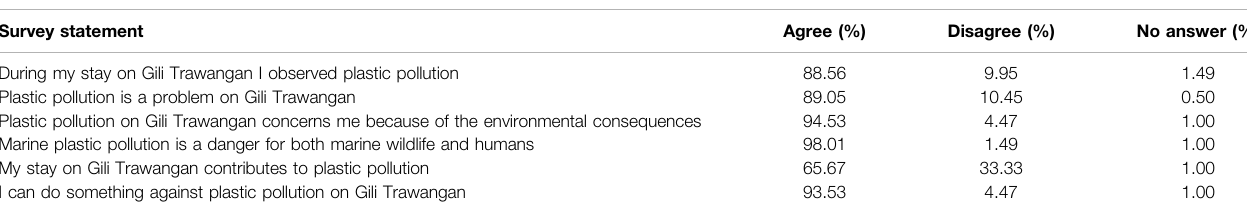
TABLE 4 | Survey results about plastic pollution on Gili Trawangan.